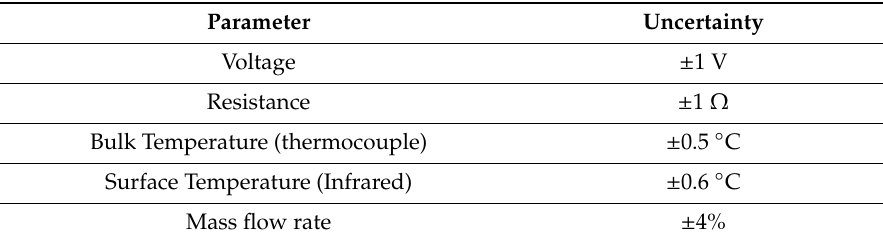
Table 2. Uncertainties in the test